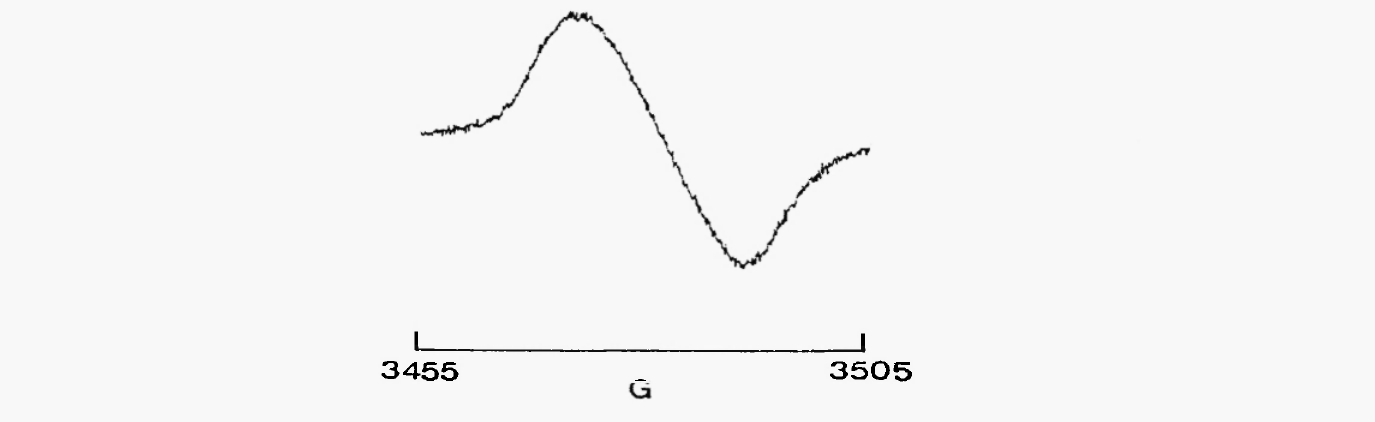
Figure 1. EPR spectrum (X band) at room temperature of the semioxidized complex Cd(L)Br;.2H 2 0 powder Corrected magnetic moments have been calculated from the molar magnetic susceptibilities using